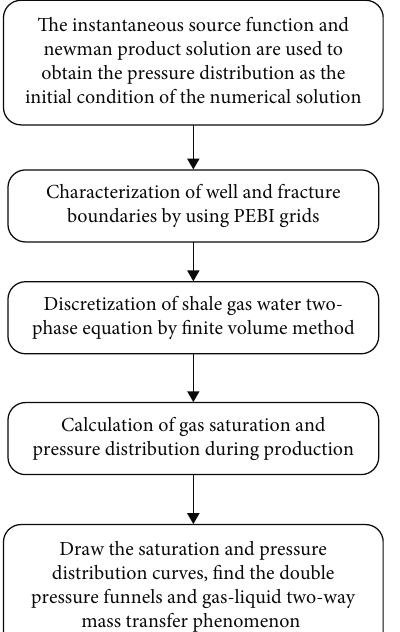
Figure 2: Flowchart of work steps.